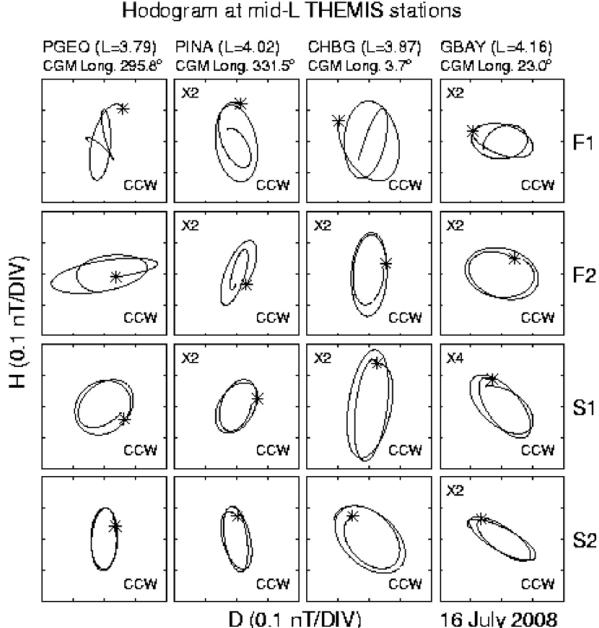
Fig. 12. The horizontal magnetic variation vectors related to ground Pi2 onsets on 16 July 2008. The dot-centered circle denotes the assumed location of the upward field-aligned current and the cross- centered circle the downward field-aligned current.